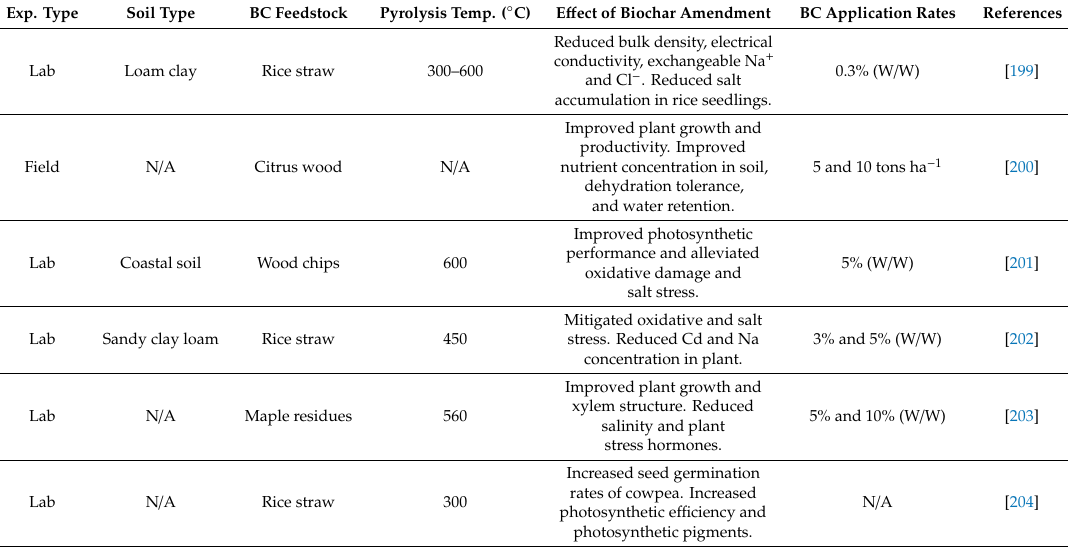
Table 5. Selected recent studies reporting the e ff ect of biochar on salt stressed soils. Exp.